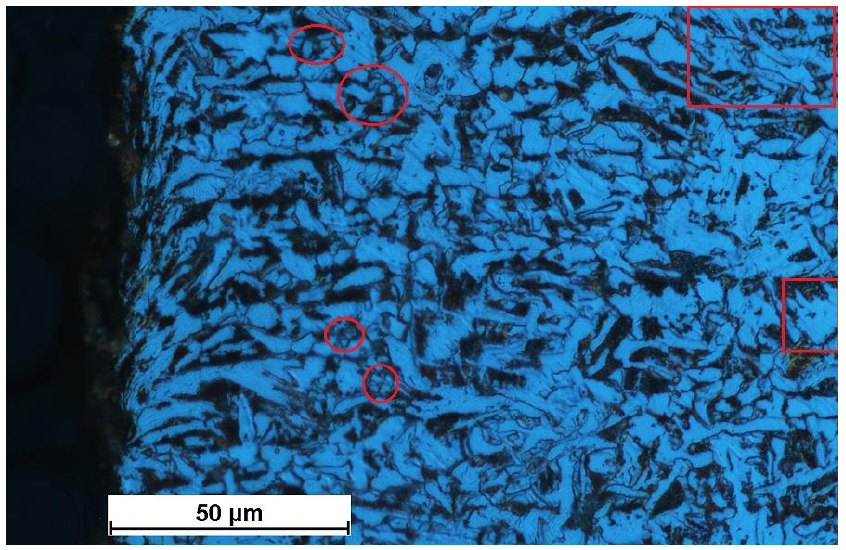
Figure 8. Recrystallization (red circles) and polygonization (red rectangles) in the microstructure of a metallographic specimen.